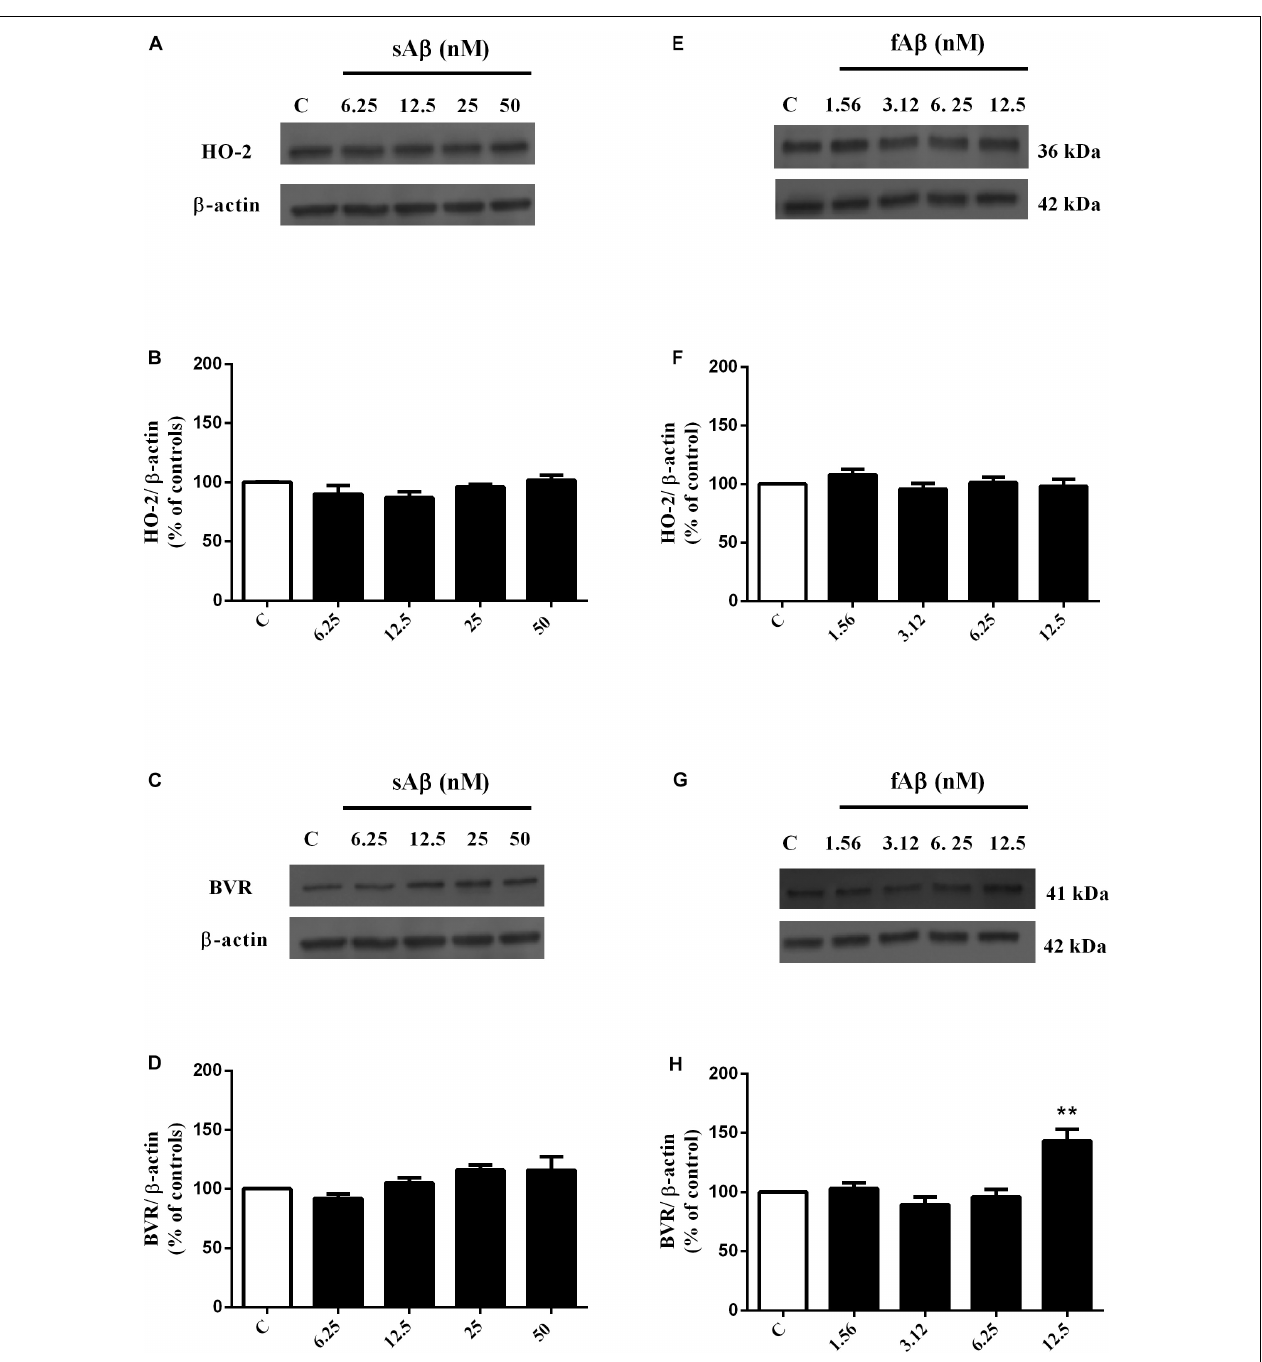
FIGURE 2 | Effects of soluble and fibrillar A β (sA β and fA β , respectively) on heme oxygenase-2 (HO-2) and biliverdin reductase (BVR) expression in SH-SY5Y neurons. SH-SY5Y cells were treated with sA β (6.25–50 nM) and fA β (6.25–50 nM) for 24 h and Western Blot was performed as described in Section “Materials and Methods.” (A,C,E,G) Show representative gels regarding HO-2 and BVR protein expression following sA β and fA β treatment, as above. Bar graphs represent the quantification of HO-2 and BVR protein levels normalized for β -actin expression. Data are expressed as mean ± SEM of 4/5 replicates per group and analyzed by One-way ANOVA followed by Tukey’s test: ** P < 0.01 vs. C (H) . C, control.